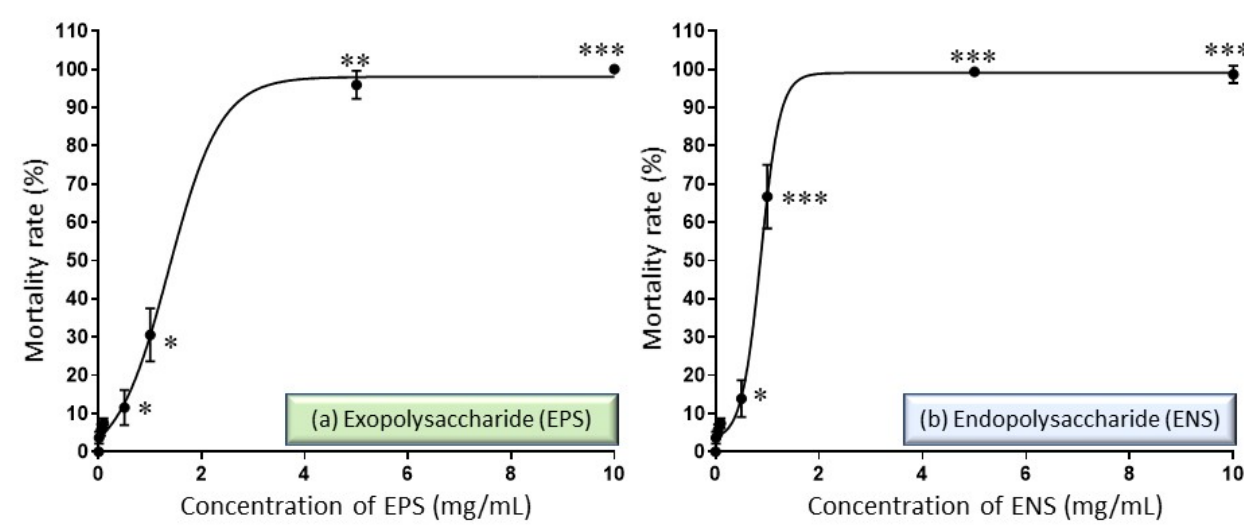
Figure 2. Effect of Ganoderma applanatum ( a ) EPS extract at concentrations of 0.01–10 mg/mL and ( b ) ENS at concentrations of 0.01–10 mg/mL on zebrafish embryos mortality rate after 120 HPF. The LC 50 value for EPS extract was 1.41 mg/mL while LC 50 value for EPS extract was 0.87 mg/mL. Symbols: * p ˂ 0.05, ** p < 0.01 and *** p < 0.001.